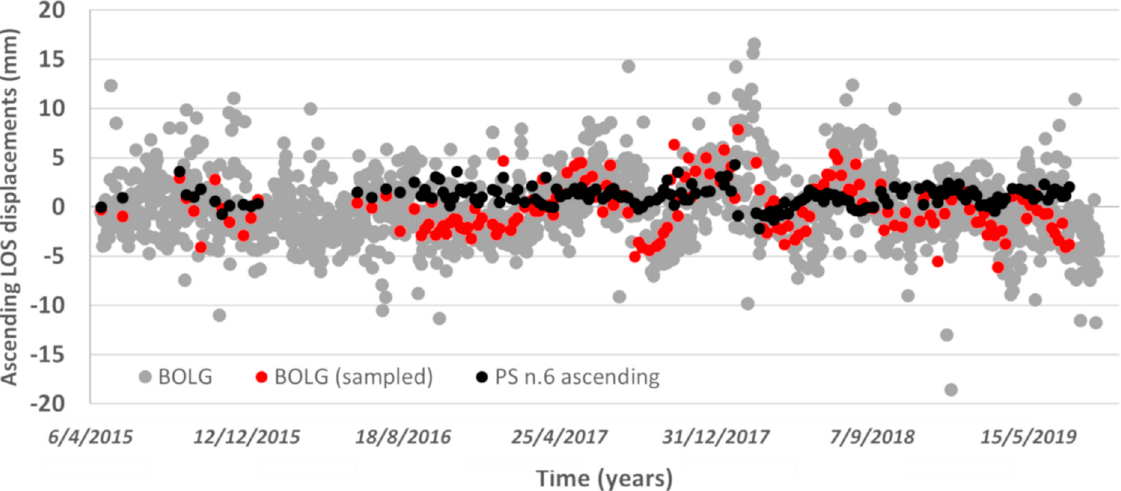
Figure 9. Comparison between BOLG and a single PS time series. Both series are oriented along the ascending LOS and aligned with respect to a common first epoch. The time in the x-axis is referred to the period under investigation and is provided in the form day/month/year.